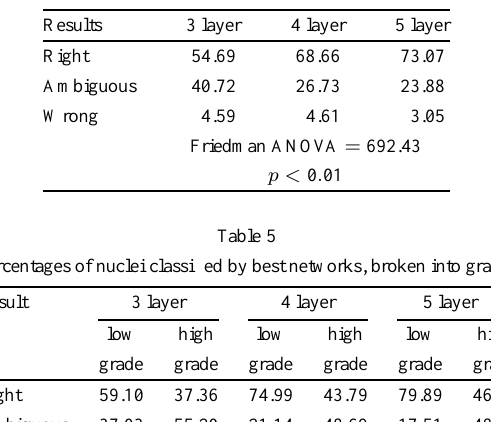
Percentages of nuclei classified by best networks. Friedman statistic shows that differences between them are significant